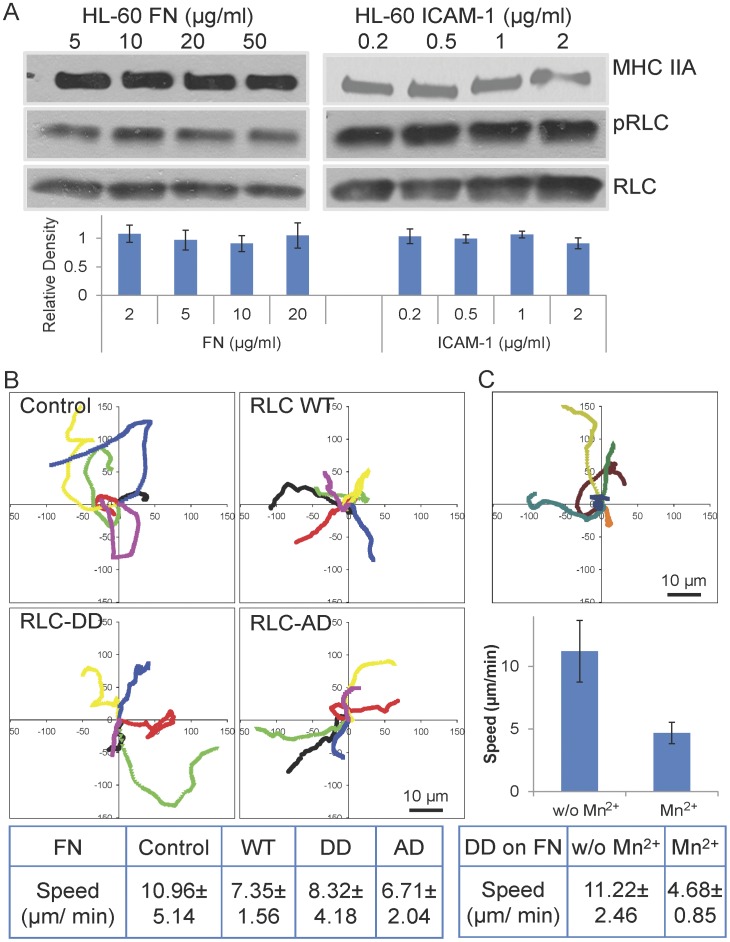
Effect of myosin II activation and Mn2+ on HL-60 cell migration.(A) Immunoblotting for pRLC shows that cells migrating on FN or ICAM-1 show similar levels. For the HL-60 cells, pRLC levels appear to be dose independent on both substrates. Representative blots are shown, and relative-fold increase of pRLC presented. The data are derived from at least three experiments for each substrate. (B) RLC activation does not affect the migratory properties of HL-60 cells on FN. HL-60 cells were doubly transfected with paxillin-mCherry and RLC, RLC-A,D, or RLC-D,D with GFP. Experimental time: 4 minutes. Scale Bar  = 10 µm. (C) Migration of HL-60 cells was inhibited by Mn2+. Three individual cells before and after Mn2+ treatment were plotted. Set 1: red; set 2: green; set 3: blue. P value  = 0.012.